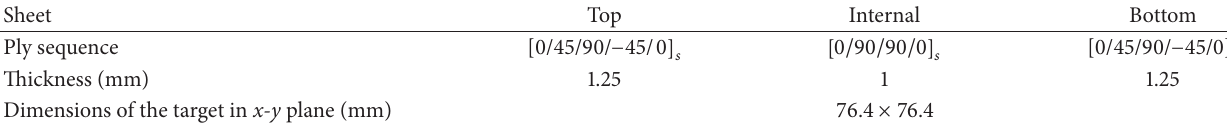
Table 2: Geometrical properties of composite laminated